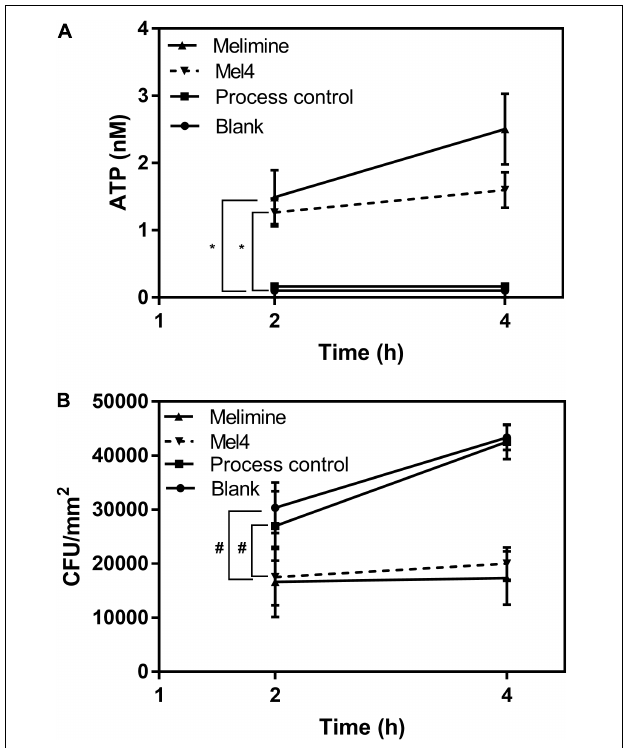
FIGURE 6 | Leakage of ATP. (A) The leakage of ATP from P. aeruginosa 6294 following incubation with surface attached melimine, Mel4, process control or blank glass. * p ≤ 0.033 compared to process control. (B) Corresponding number of viable P. aeruginosa 6294 reduced by peptides attached surfaces. # p ≤ 0.033 compared to process control. Error bars represent means ( ± SD) of three independent repeats in triplicate.